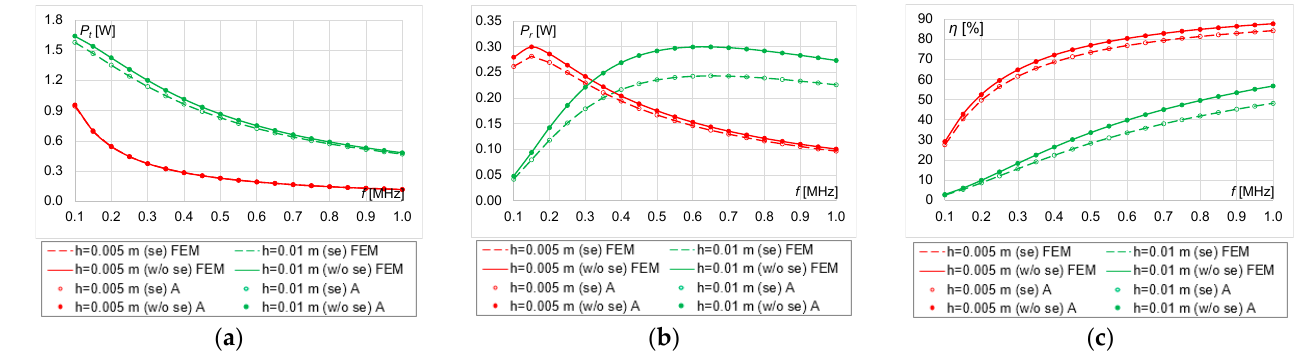
Figure 8. Results for n = 10 for the cases with and without skin effect: ( a ) P t , ( b ) P r , ( c ) η .